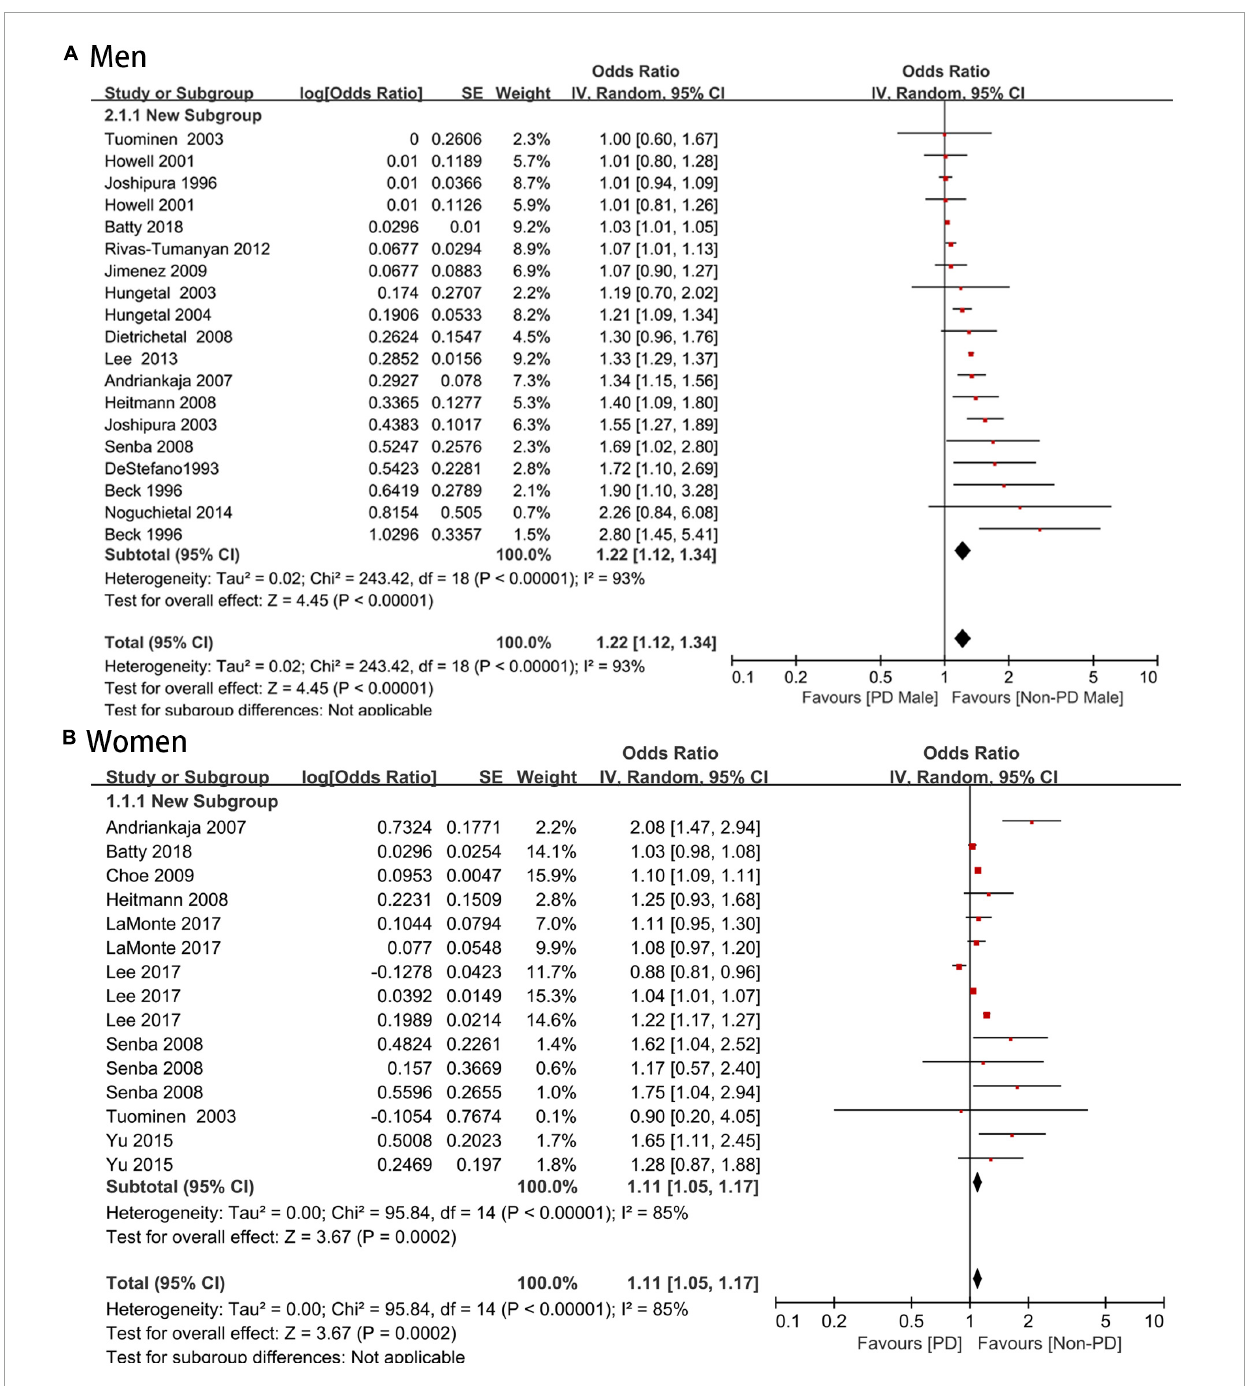
FIGURE4 (A,B) Forest plot of the risk of cardiovascular disease in periodontal disease patients by sexes. In the forest plot, the diamond indicates the pooled estimate. Red boxes are relative to study size and the black vertical lines indicate 95% CIs around the effect size estimate.